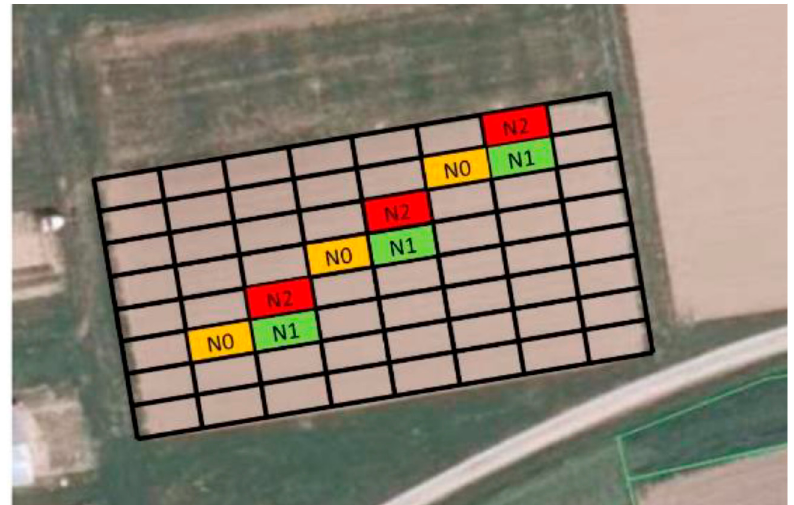
Figure 1. Location of experimental plots (4 × 8 m), fertilized with calcium ammonium nitrate throughout the whole long-term field experiment.